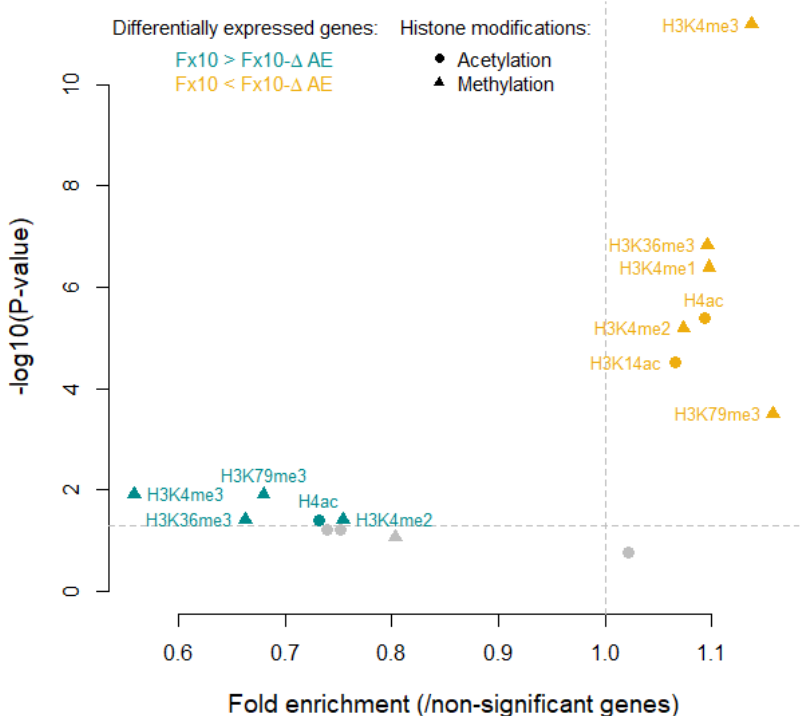
Figure 8. Enriched or depleted histone modifications in the Fx10- ∆ AE mutant. Possible histone modifications (3 acetylations and 5 methylations) were sought for all genes. The average ratios of acetylations and methylations in up- and downregulated genes were compared to those of non- significant genes (Kruskal–Wallis tests). p -values were corrected for multiple testing with Benjamin–Hochberg adjustment. Not-significantly enriched/depleted histone modifications are shown in gray, whereas significant ones ( p -value < 0.05) are colored. The histone modifications data are available from [28].